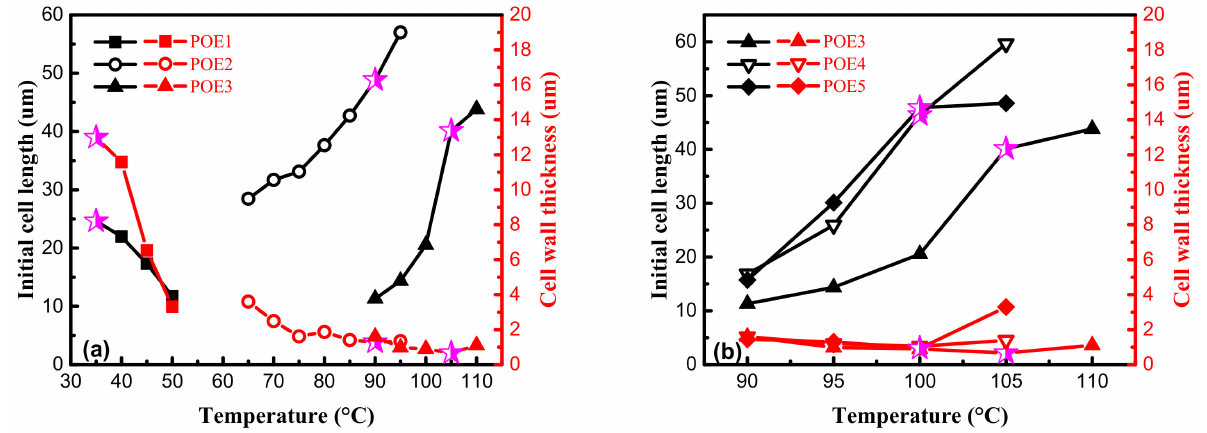
Figure 18. Effect of saturation temperature on initial cell length and cell wall thickness. ( a ) POE samples with same MI; ( b ) POE samples with same octene